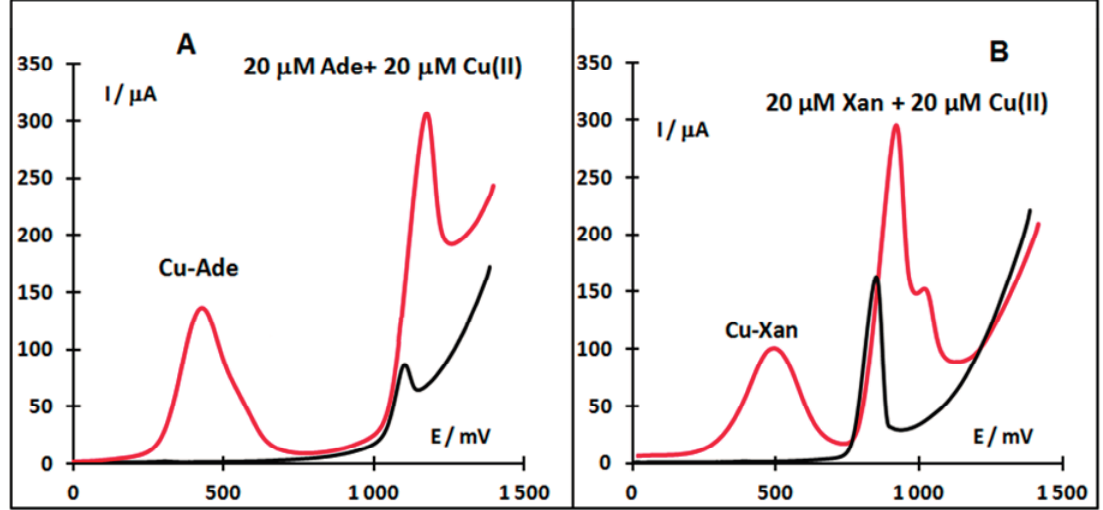
Figure 6. Linear sweep voltammograms of Ade ( A ) and Xan ( B ) in the absence (black line) or presence (red line) of Cu(II) ions. Acetate buffer pH 5.1; scan rate 800 mV/s; c Ade = 20 μ M, c Xan = 20 μ M, c Cu (II) = 20 μ